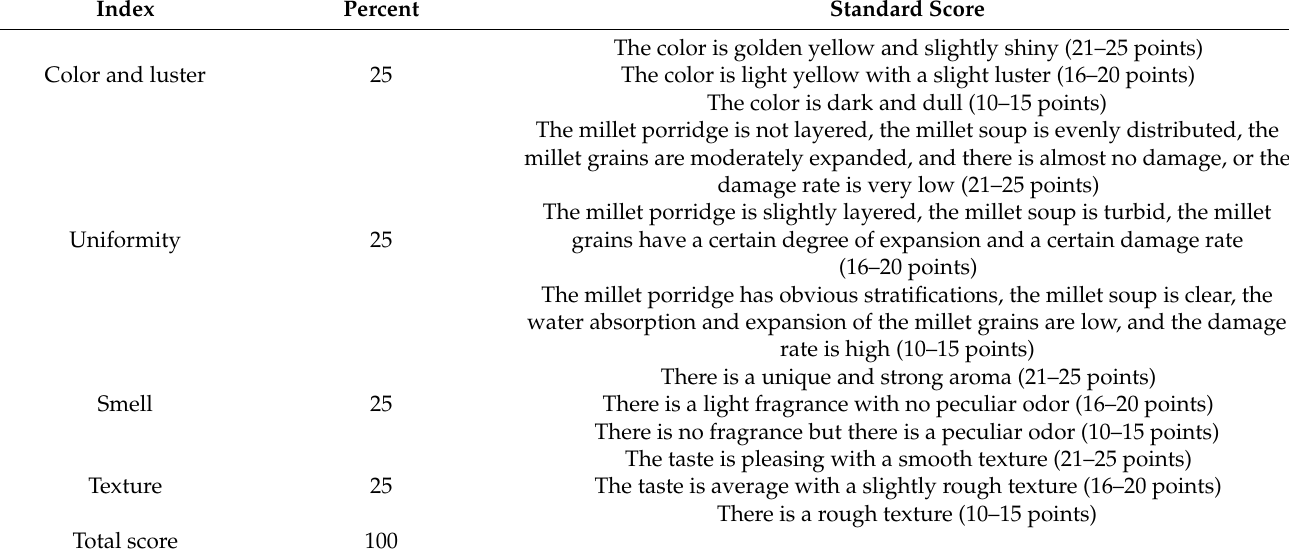
Table 1. Scoring rules for sensory evaluation of millet